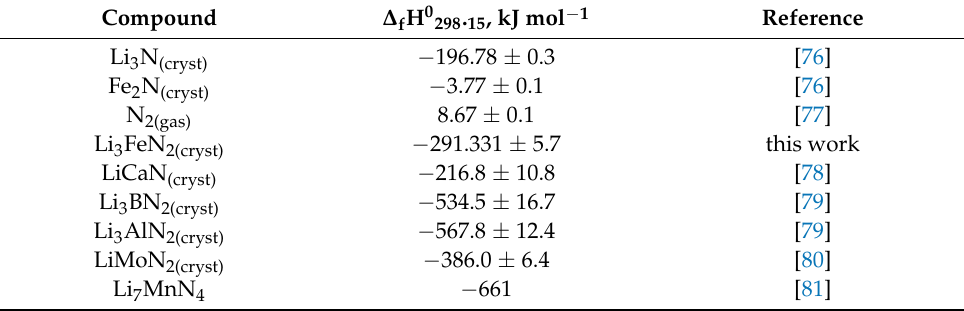
Table 4. Standard enthalpies of formation from elements ( ∆ f H 0